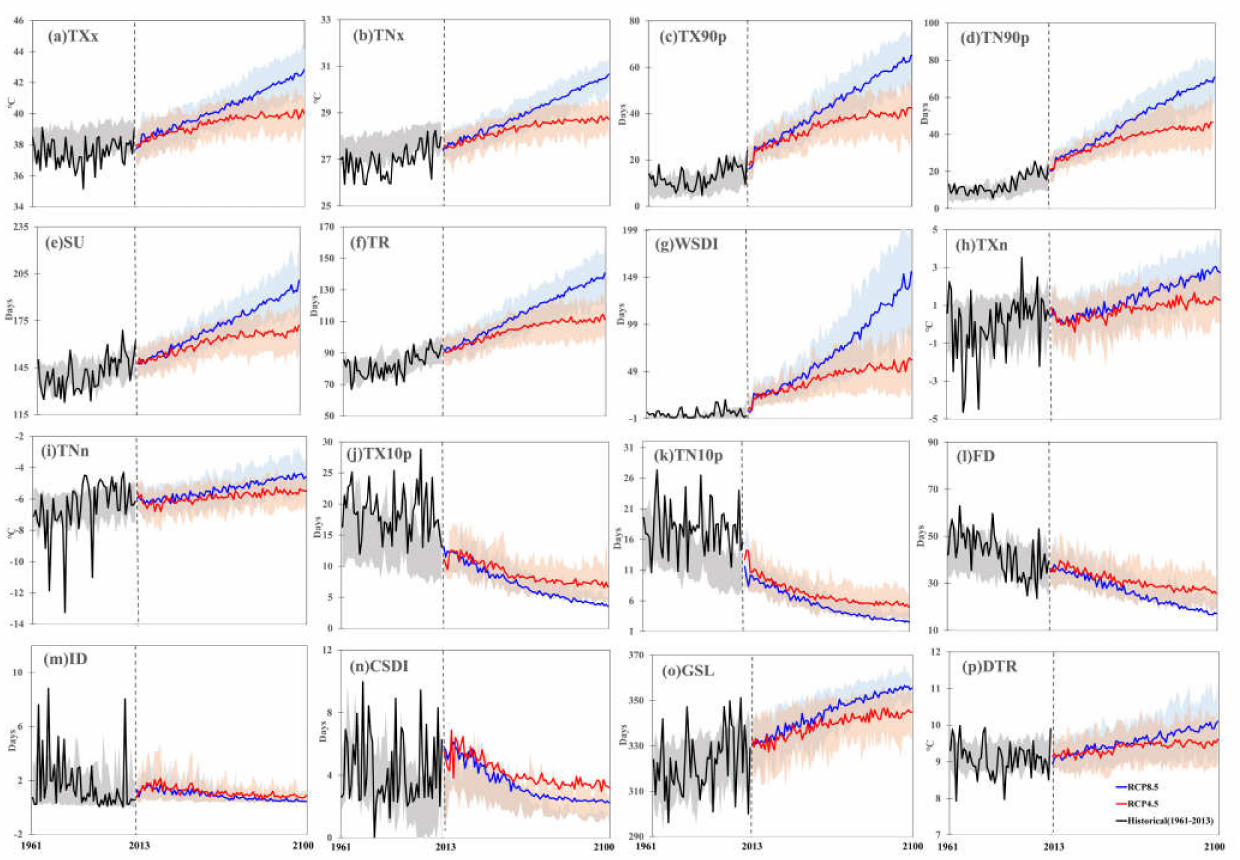
Figure 7. Time series (1961–2100) of the multi-model ensemble simulated extreme temperature indices ( a , TXx; b , TNx; c , TX90p; d , TN90p; e , SU; f , TR; g , WSDI; h , TXn; i , TNn; j , TX10p; k , TN10p; l , FD; m , ID; n , CSDI; o , GSL; p , DTR) under RCP 4.5 and RCP 8.5 averaged across the HRB. The top and bottom bounds of the shaded area are the 90th and 10th percentile of the annual values, respectively, for the 28 GCM simulation changes in the temperature